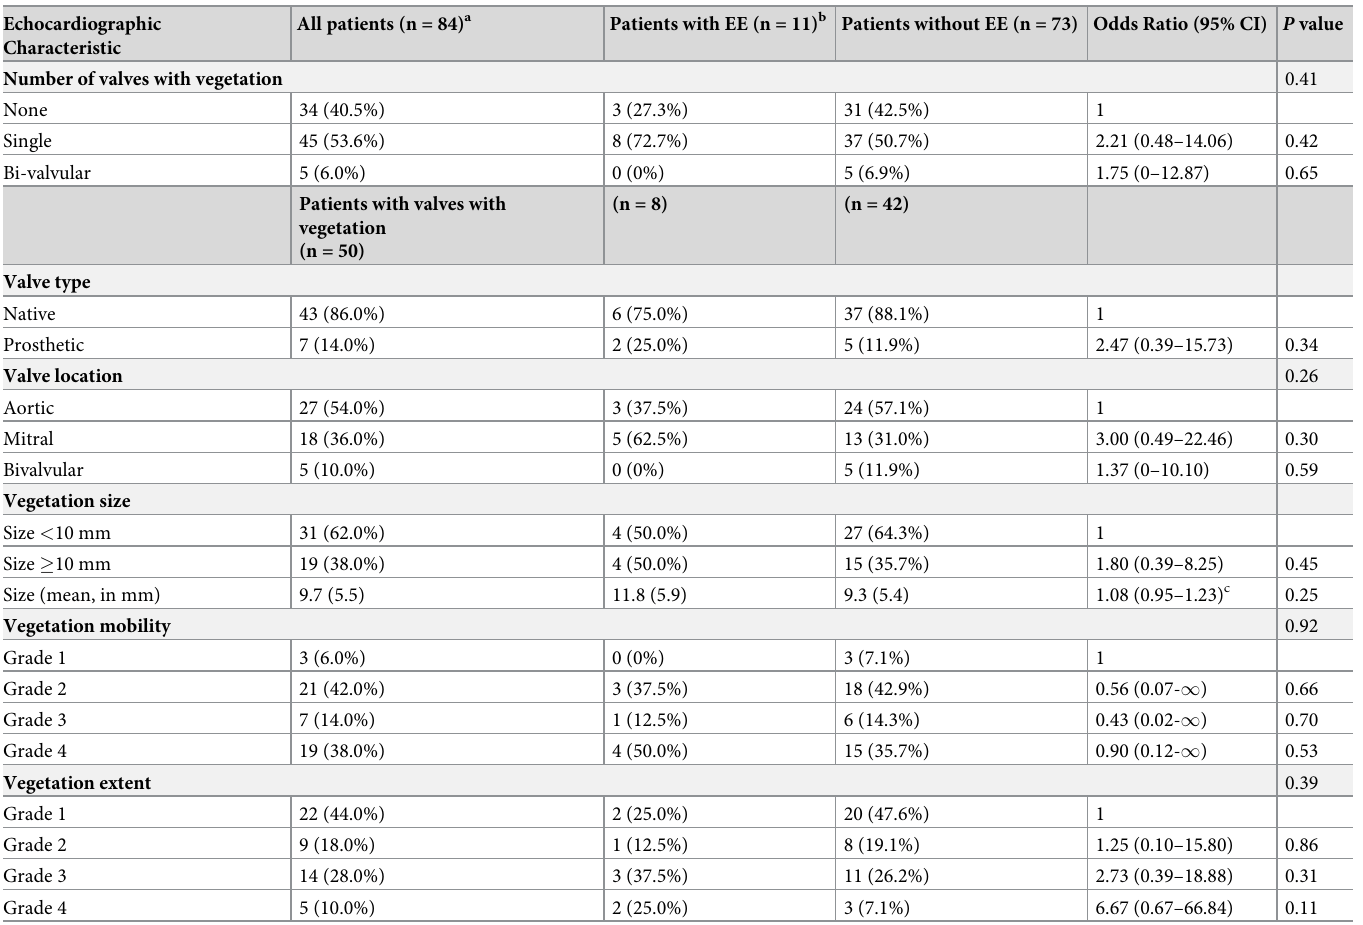
Table 3. Echocardiographic characteristics of patients with an embolic event occurring after echocardiography. Echocardiographic